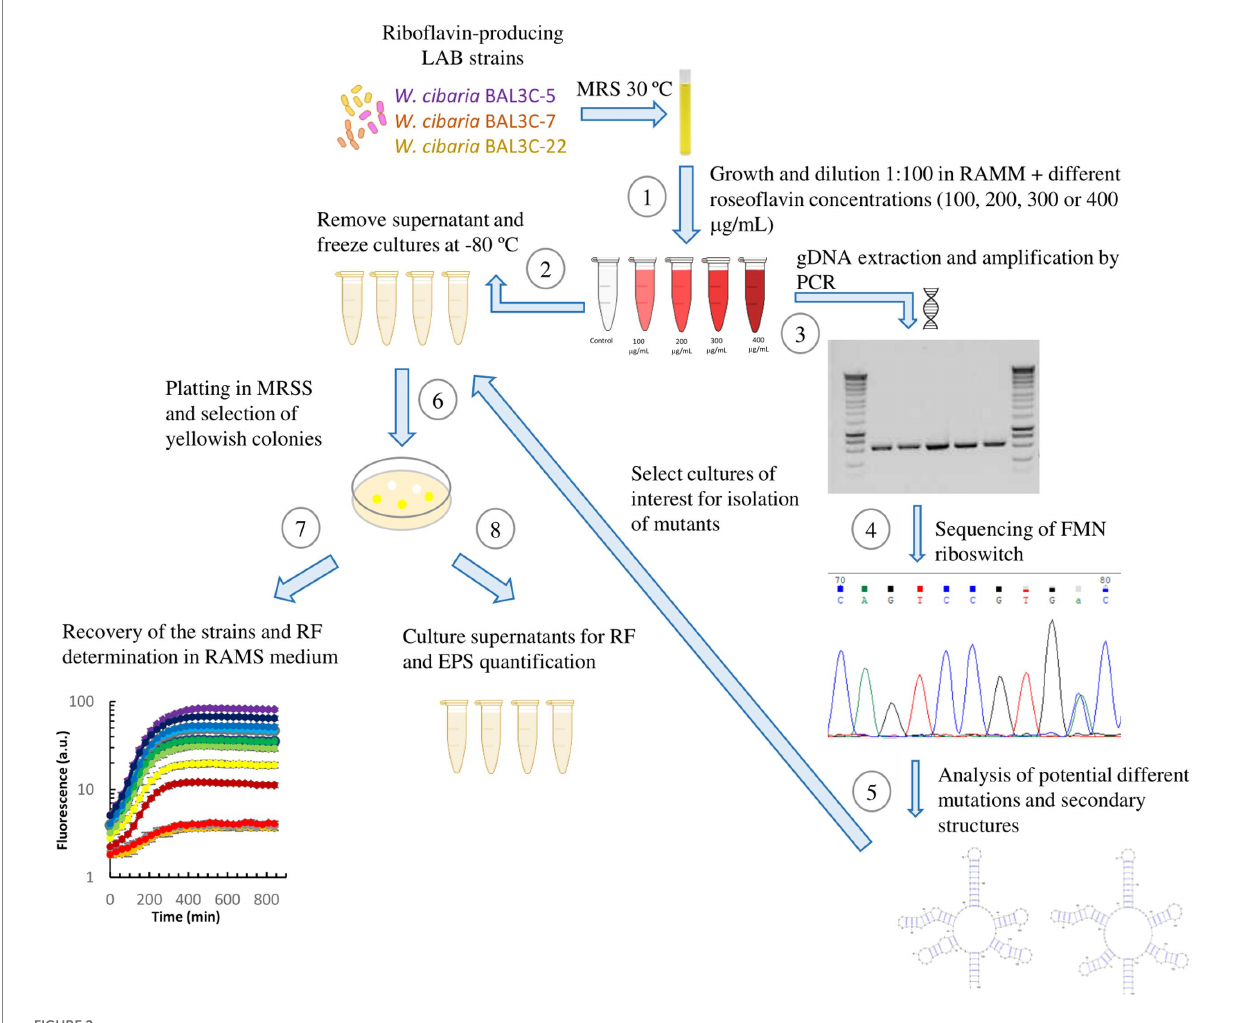
FIGURE 2 Schematic representation of the methodology followed for the selection and characterization of mutant strains. (1) Cultures reconstituted in MRS were grown in RAMM supplemented with different roseoflavin concentrations for 48 h at 30 ° C. (2) Then, aliquots of the cultures were stored at − 80 ° C. Another portion of bacterial cultures was used for gDNA extraction and amplification of the FMN riboswitch region. Amplified sequences were tested in agarose gels (3) and submitted to sequencing (4) . After, detection and location of point mutations in the FMN riboswitch aptamer by analysis of DNA sequencing chromatograms. (5) The predictive mutated aptamer structures were analyzed, and the Weissella cibaria roseoflavin-treated cultures, whose DNA showed the most promising mutations, were plated in MRSS and (6) yellow colonies were selected for isolation of the RF-overproducing strains. Then, the isolated mutant strains were subjected to analysis of RF production and growth in real time (7) , as well as quantification of RF and EPS production after 16 h of growth (8)